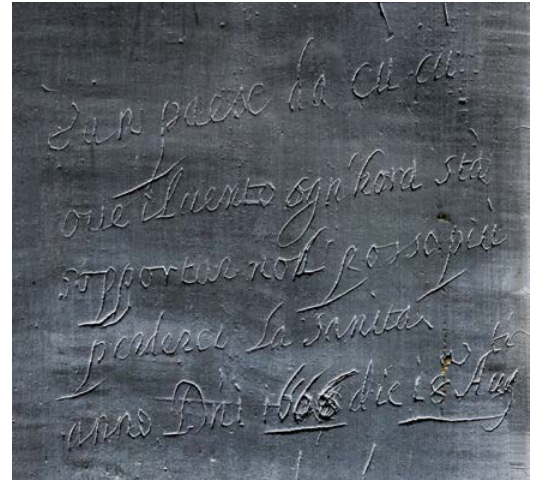
Figure 11 – Graffito ‘È un paese da cùcù’. Photo by Manuele